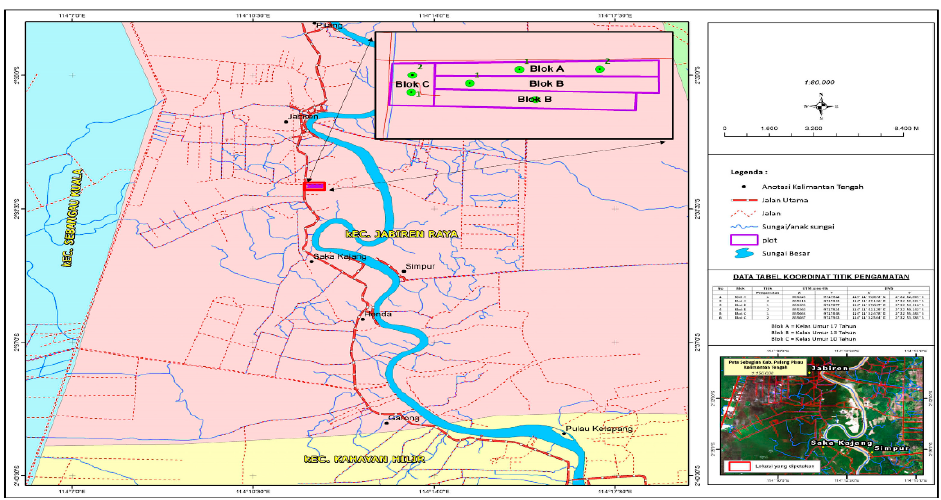
Figure 1. Research location in Jabiren Village. Carbon stock measurements were carried out on D. polyphylla located on communi-ty-owned land. The jelutung swamp stands were divided into 17 years, 13 years, and 10 years of age classes. The sketch of the research location is presented in Figure 2.